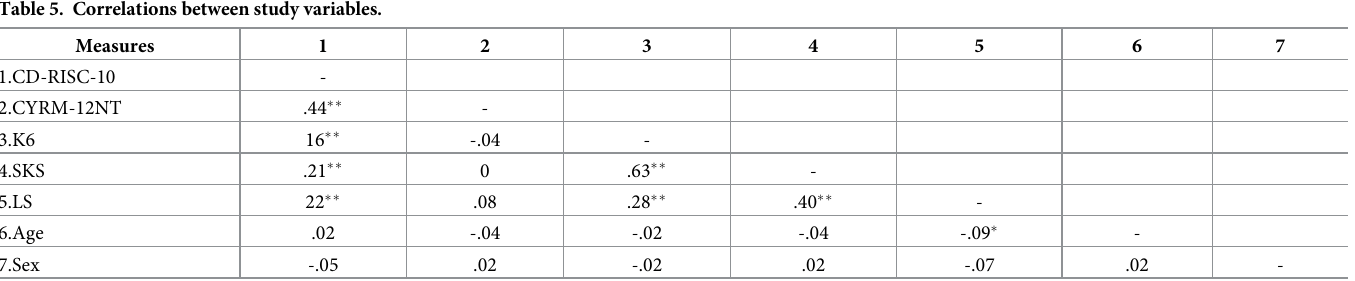
Table 5. Correlations between study variables.